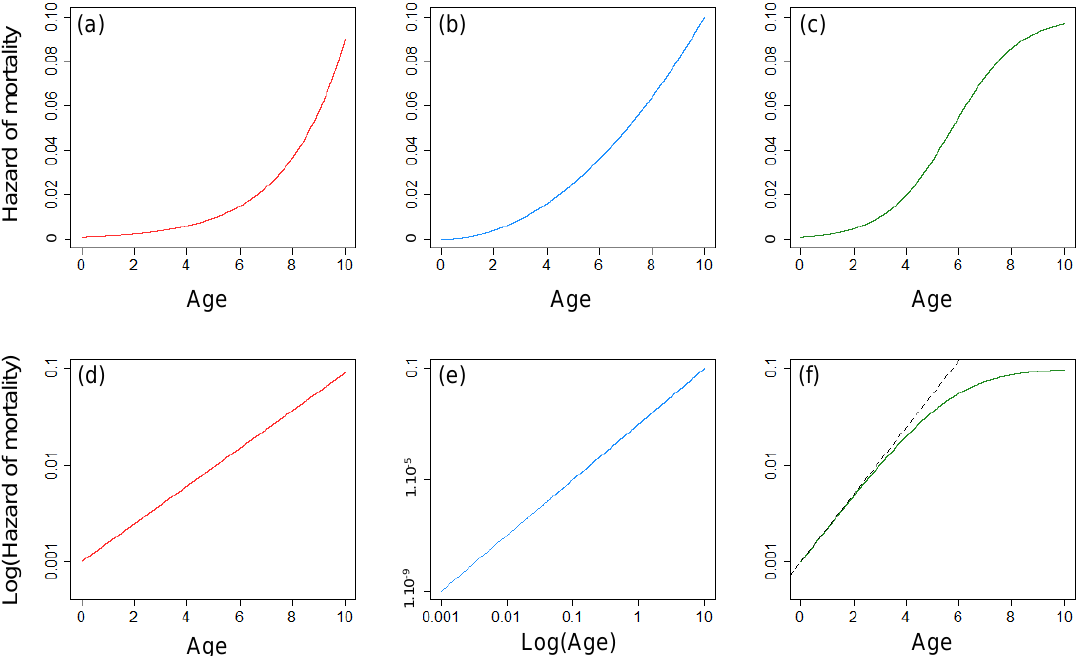
Figure 1. Plot of the three standard models used to describe age-dependent changes of mortality throughout the adult stage. ( a ) Hazard of mortality as a function of age from a Gompertz model, in ( d ), the log of the hazard of mortality increases linearly with age. ( b ) Hazard of mortality as a function of age from a Weibull model, in ( e ), the log of the hazard of mortality increases linearly with the log of age. ( c ) Hazard of mortality as a function of age from a logistic model, in ( f ), the logistic model is close to a Gompertz model at early adult ages (dashed line), but the rate of increase gradually decelerates with increasing adult